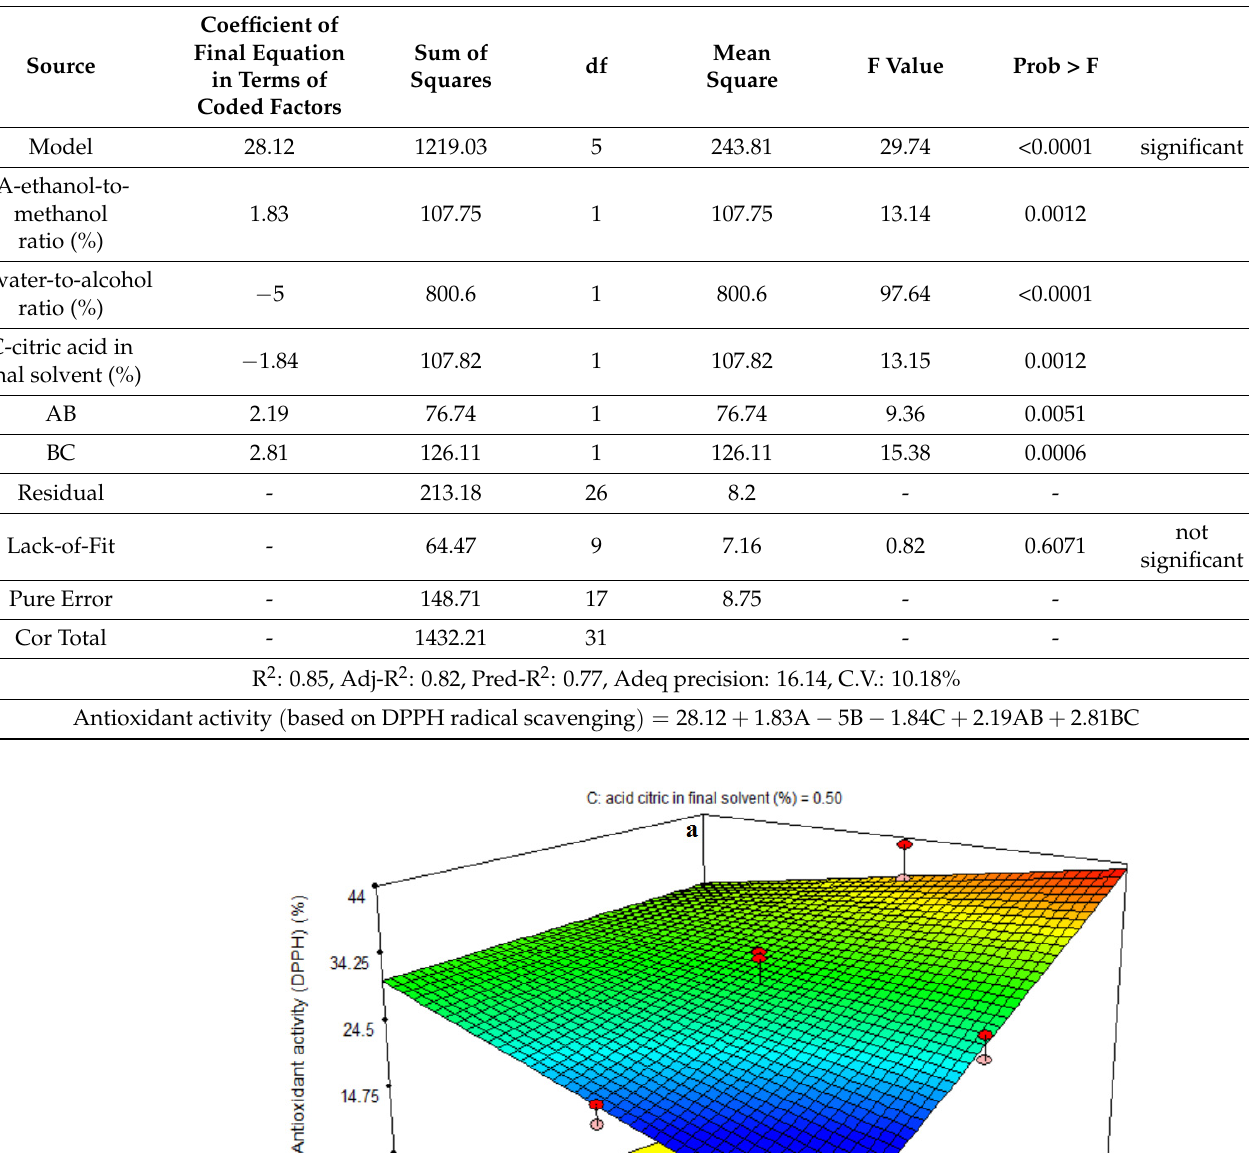
Table 5. The analysis of variance (ANOVA) of antioxidant activity in terms of DPPH radical scaveng- ing activity (second-order fitted polynomial model) in bioactive compound extraction of eggplant peel by the different solvent combinations.